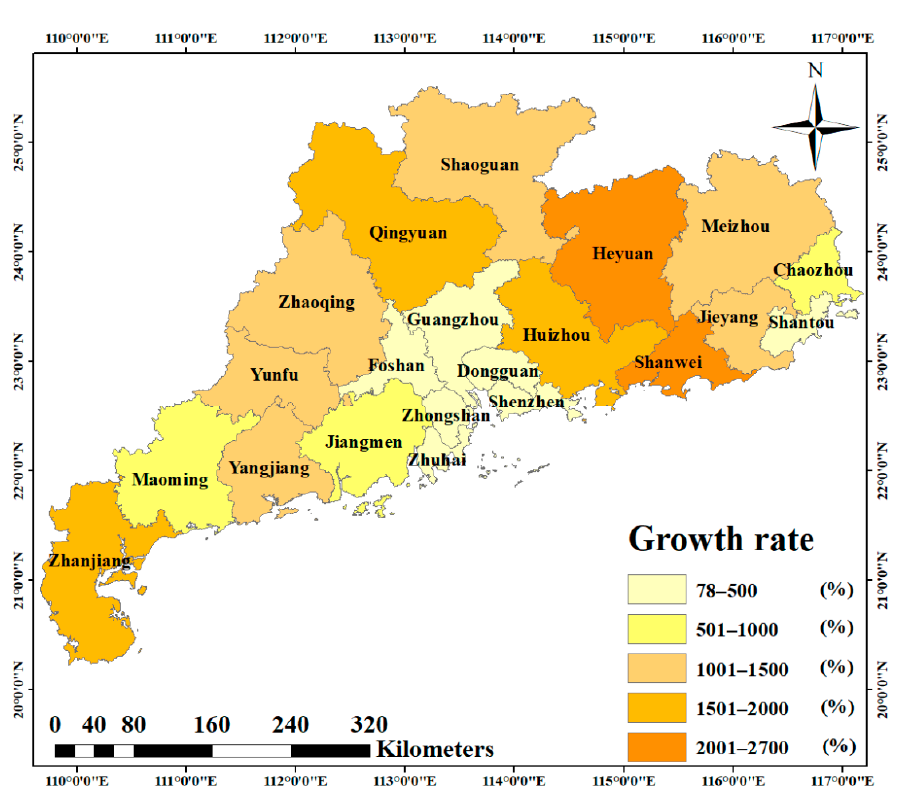
Figure 4. Luminous growth rate of prefecture-level cities.